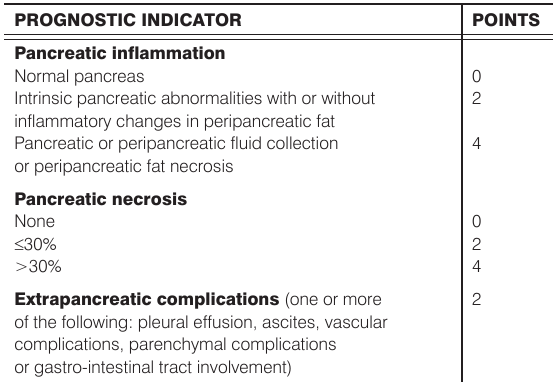
Table 4. The Extra-Pancreatic Inflammation on Computed Tomog- raphy (EPIC) score [ 8 ]. SIGNS OF EXTRAPANCREATIC